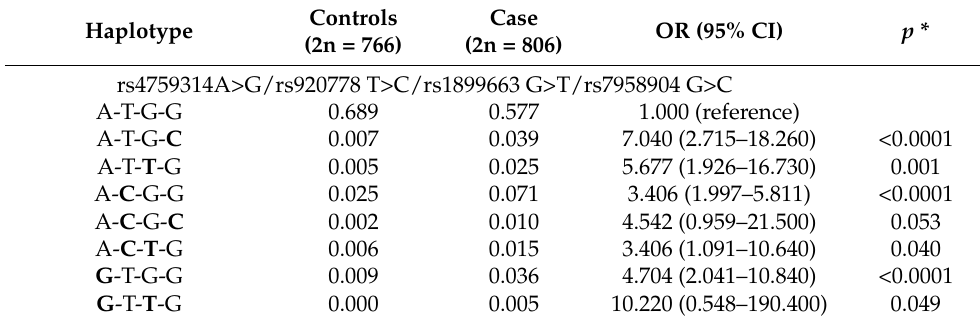
Table 3. Haplotype analysis of HOTAIR polymorphisms in RPL and controls